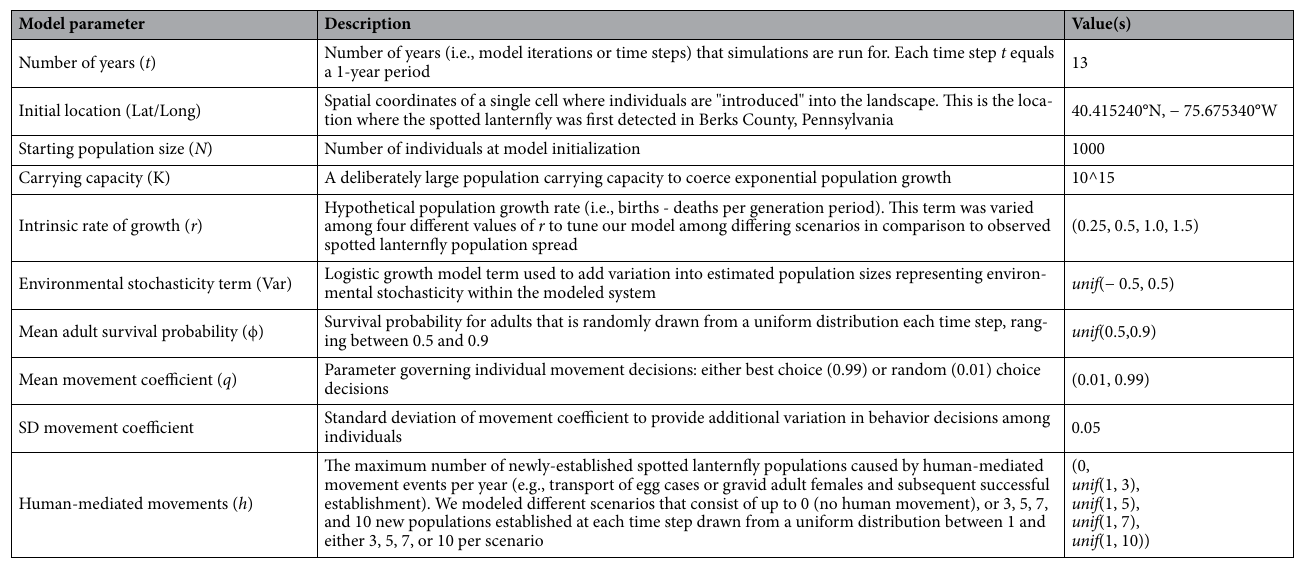
Table 1. List of model parameters, descriptions, and initial conditions for agent-based model of spotted lanternfly movement under differing